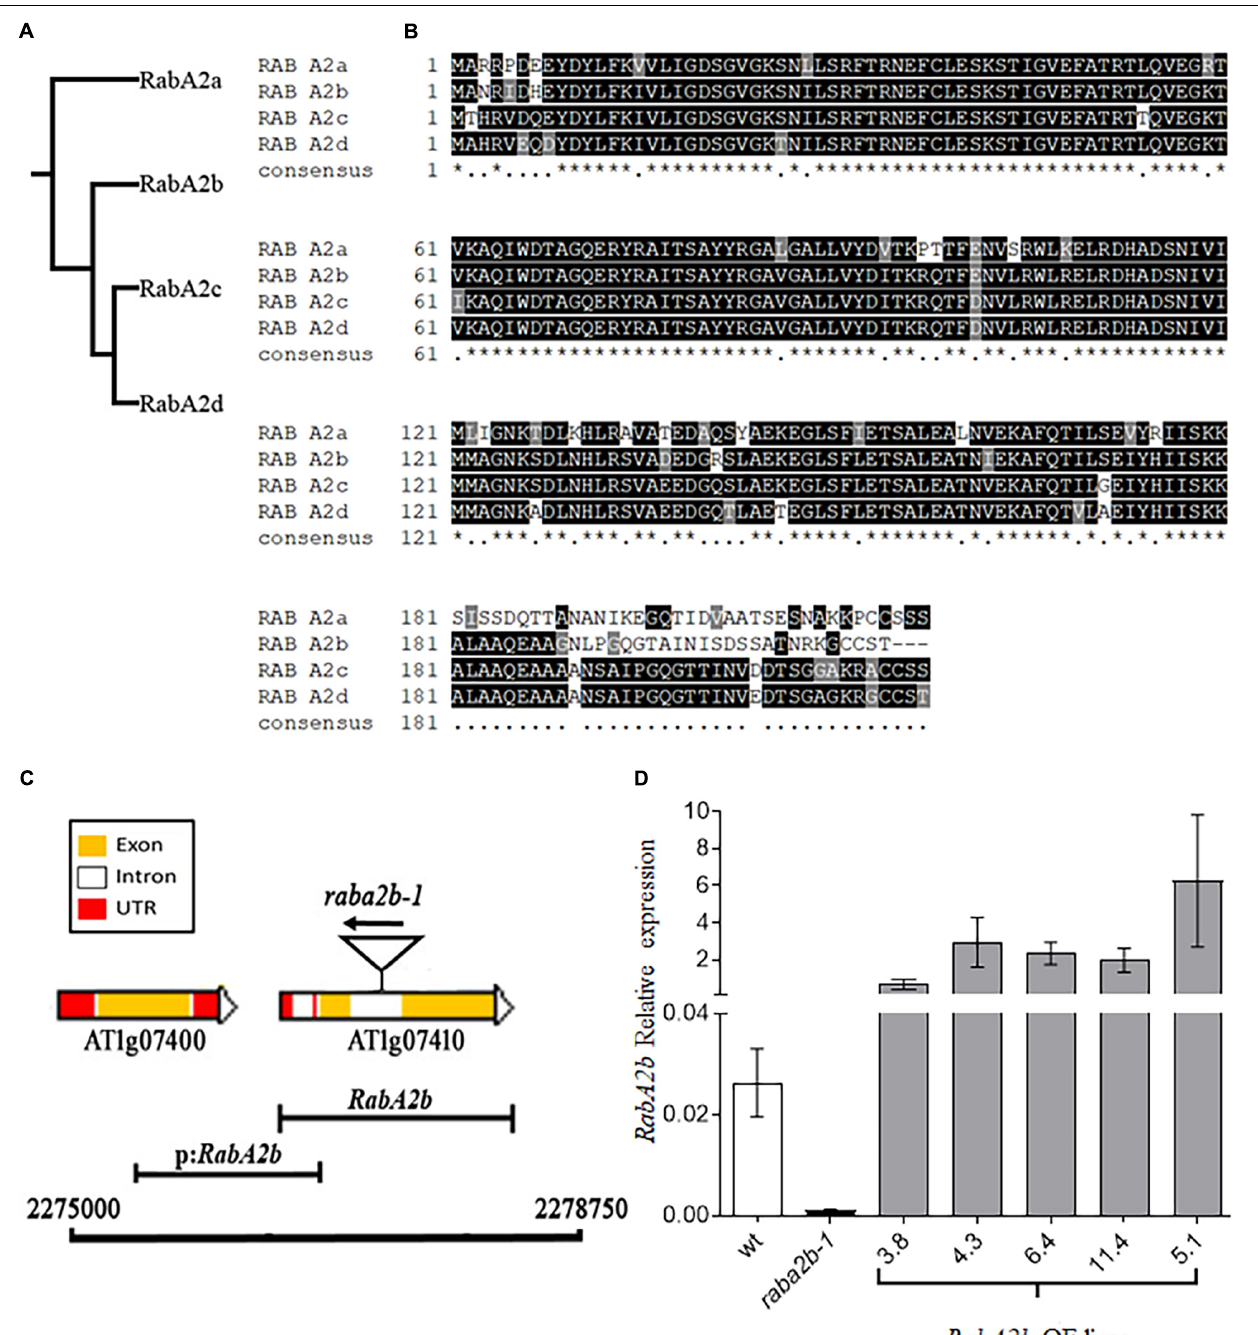
FIGURE 1 | Molecular features AtRabA2b . (A) Phylogram of the RabA2 family using a multiple sequence alignment program (Clustal Omega) that uses seeded guide trees and HMM (Hidden Markov model) profile-profile techniques to generate alignments and phylogenetic tree. (B) Multiple sequence alignment, produced by ClustalW, aligns different RabA2 homologs according to their similarities in amino acid sequence. The amino acid shaded in Black, highlights the conserved residue, gray highlights the non-conserved amino acid but similar in properties and non-shaded residues are non-conserved. (C) Physical map of the RabA2b gene showing 3.75 kb region on Chromosome 1, between coordinates 2,27,500–2,24,500 comprising RabA2b gene (AT1g07410) and its promoter ( p:RabA2b ). The positions of the T-DNA (GABI_638G09) insertion is shown by the triangle. Color coding is for yellow, white and red is for – exon, intron and UTR region, respectively. The 1 kb putative promoter region cloned for tissue specific transcriptional fusion (GUS expression) in this study is represented by black capped line labeled as p:RabA2b. (D) Expression Analysis of RabA2b in over-expressing (OE) plants. Real-time PCR analysis of wild-type (WT), T-DNA insertion mutant rabA2b1-1 (GABI_638G09) and RabA2b transgenic Arabidopsis plants, showing the expression in different T3 homozygous transgenic lines (line 3.8, 4.3, 6.4, and 11.4) with negligible expression in rabA2b mutant. Data are mean ± SE from three biological replicates each with three technical replicates. The “*” (asterisk) indicates positions which have a single, fully conserved amino acid